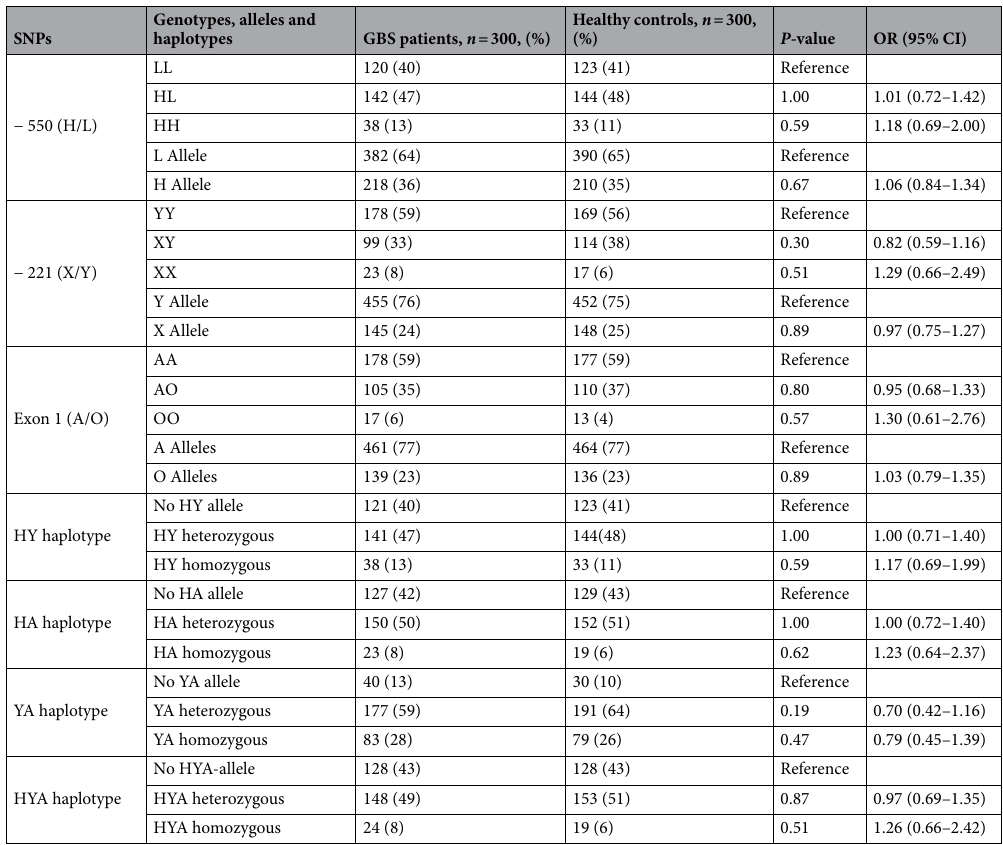
Table 2. Associations of MBL2 polymorphisms among patients with GBS and healthy controls. The Bonferroni-adjusted significance threshold was 0.0167 for genotypes and 0.025 for alleles. SNPs single nucleotide polymorphisms, GBS Guillain Barré syndrome, P-value probability value, OR odds ratio, 95% CI 95% confidence